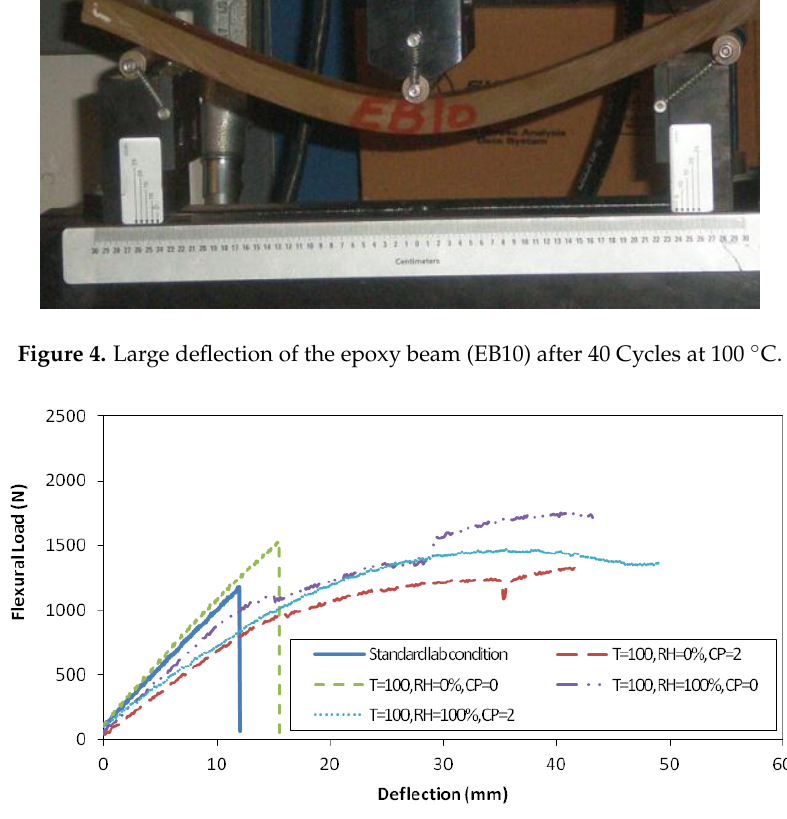
Figure 5. Flexural load-mid span deflection curves after 40 cycles under the conditions of 100 °C, humidity (0% and 100%), cycle period (Cp = 0 and 2).